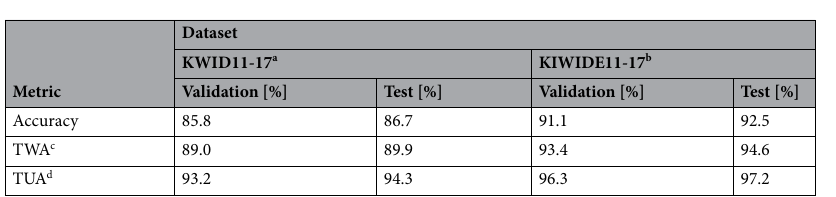
Table 6. Individual killer whale classification results (101-classes), while training two versions of FIN- IDENTIFY, using the initial KWID11-17 or KWIDE11-17 datasets. a KWID11-17 Killer Whale Individual Dataset 2011–2017. b KWIDE11-17 Killer Whale Individual Dataset Extended 2011–2017. c TWA Top-3 Weighted Accuracy. d TUA Top-3 Unweighted